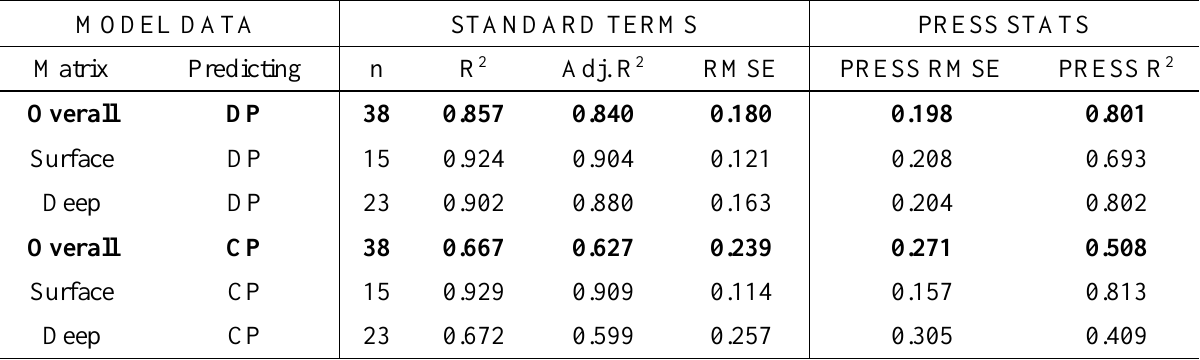
Table 1. Summary data for direct polarisation and cross polarisation peak fitting MLR models incorporating different depth intervals (0–40 cm, > 40 cm). The models predict the mass percent of PyC in a sample on the log 10 scale, therefore RMSE values are given in the log 10 transformed scale. Bold type indicates the overall models that are the focus of analysis. DP refers to direct polarisation and CP refers to cross polarisation, both of which are methods for pyrogenic carbon